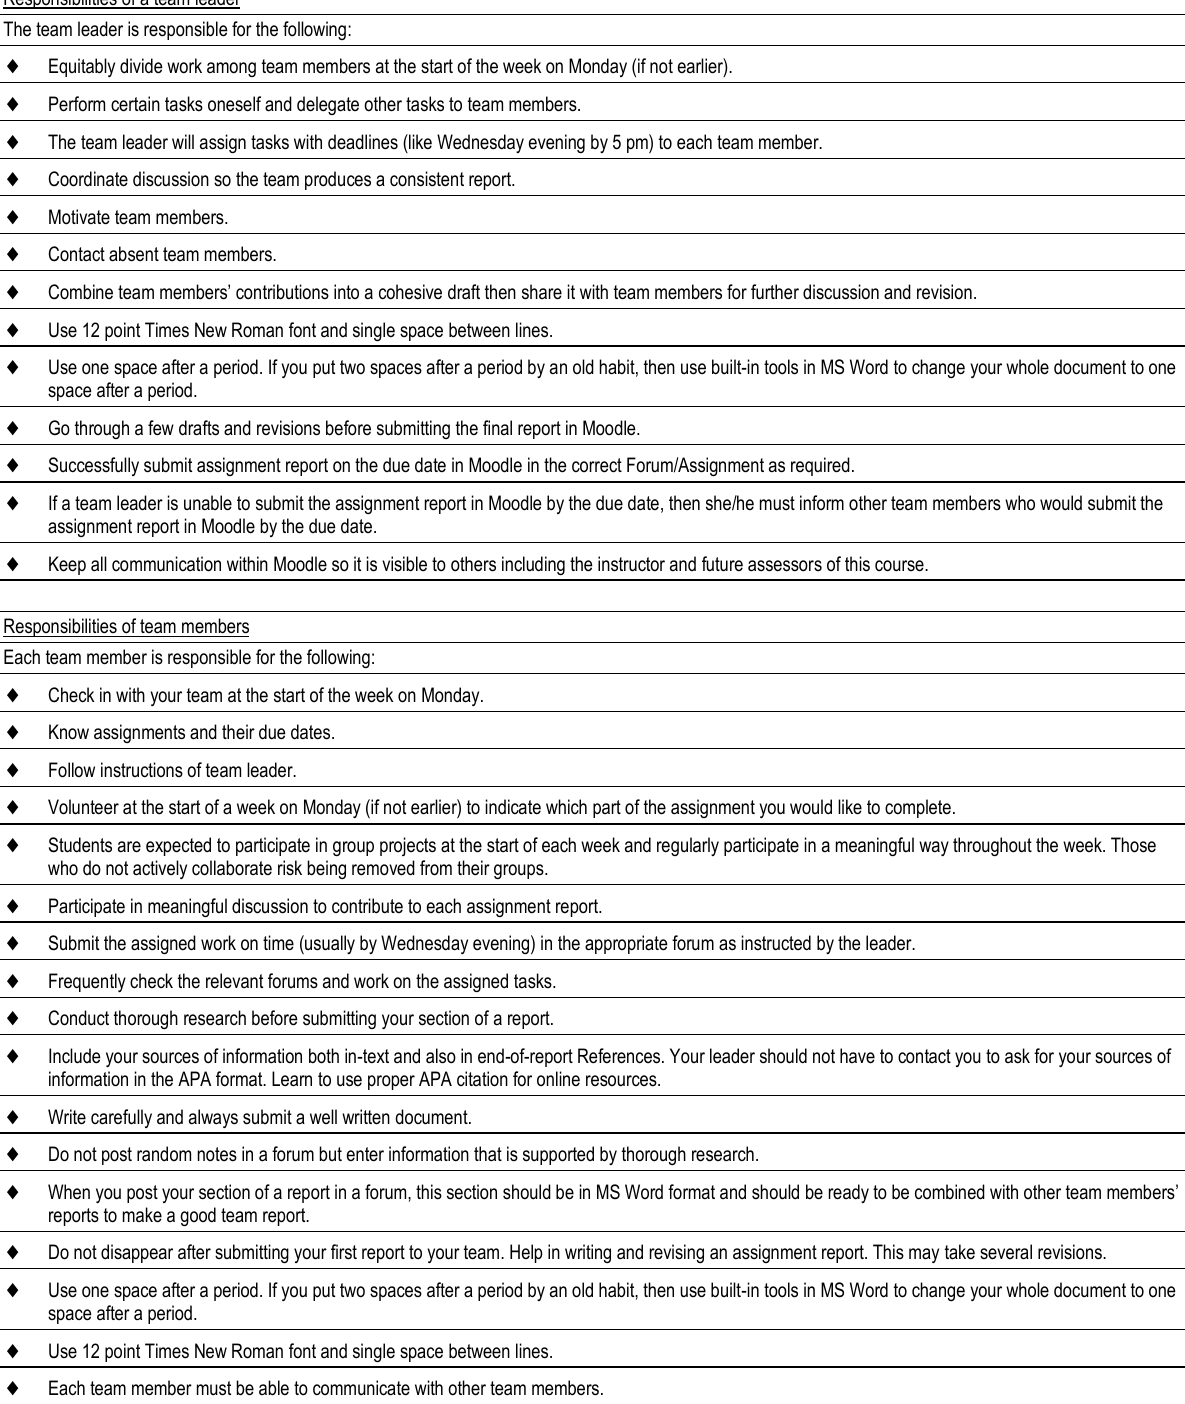
Table 1. Responsibilities of team leaders and team